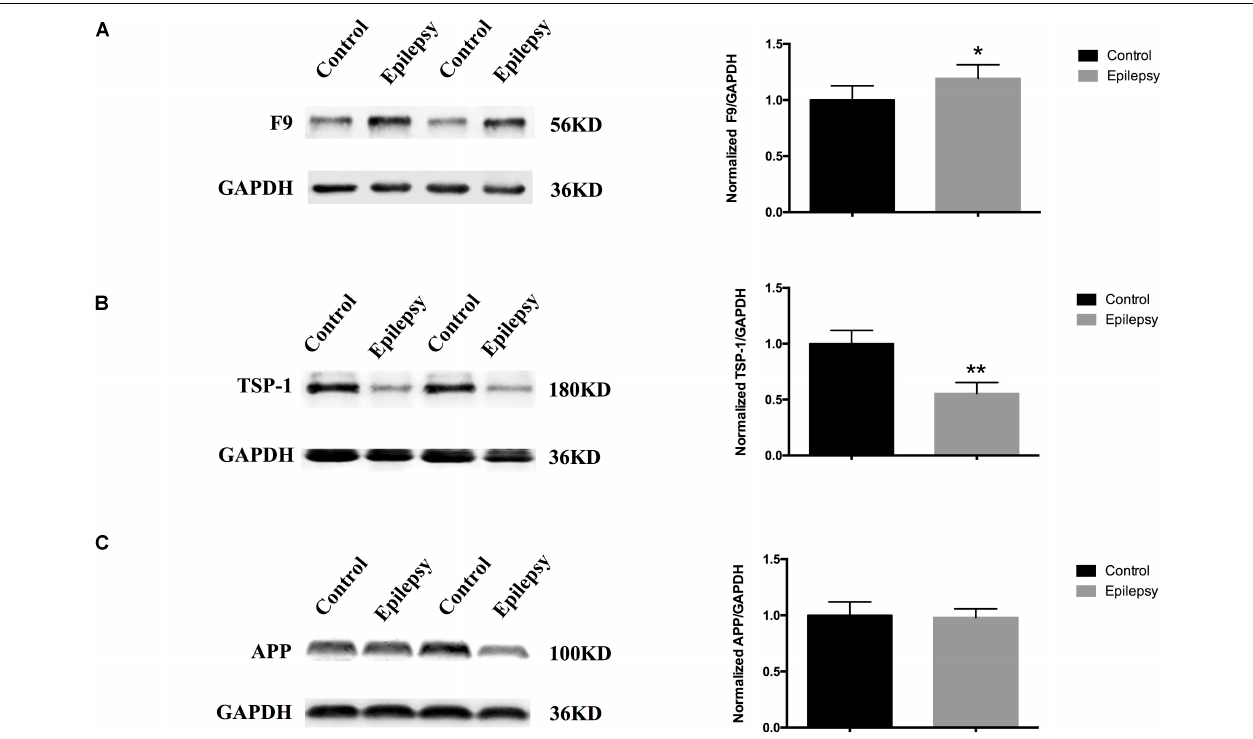
FIGURE 4 | Expression of F9, TSP-1 and APP in serum exosomes from patients with epilepsy. Western blots demonstrated that (A) exosomal F9 protein was expressed at higher levels in serum from epilepsy patients than healthy controls ( n = 25 in each group, ∗ P < 0.05); (B) exosomal TSP-1 protein was expressed at lower levels in serum from epilepsy patients than healthy controls ( n = 25 in each group, ∗∗ P < 0.01); and (C) exosomal APP protein was not significantly different in serum from epilepsy patients than healthy controls ( n = 25 in each group). Mean ± SEM Student’s t -test was performed.